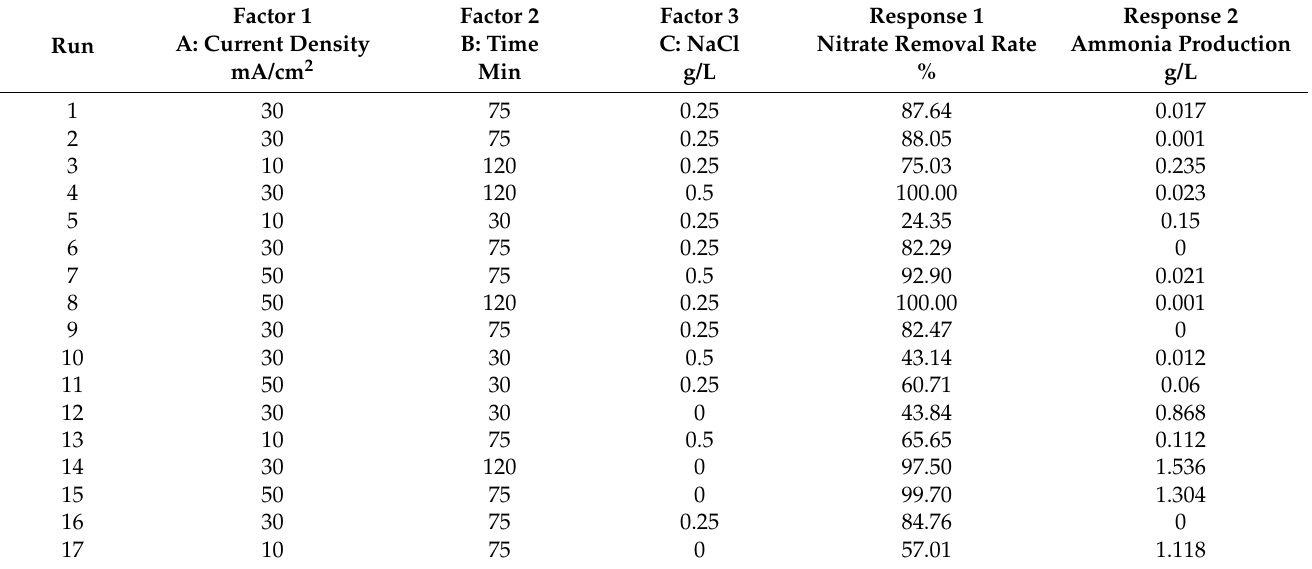
Table 2. Observed nitrate and ammonia